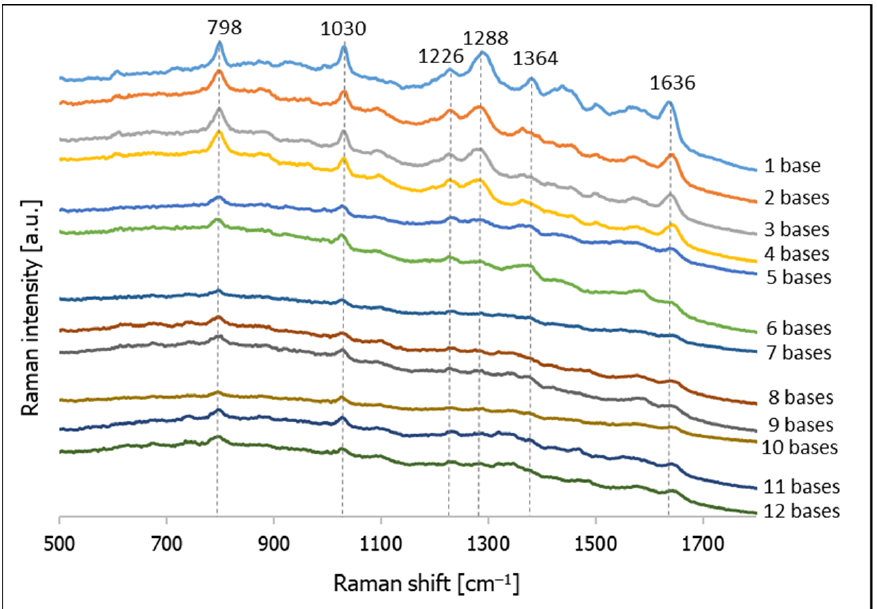
Figure 5. SERS spectra of thiolated DNA having various chain length deposited on gold nanoparticles using a freezing step.